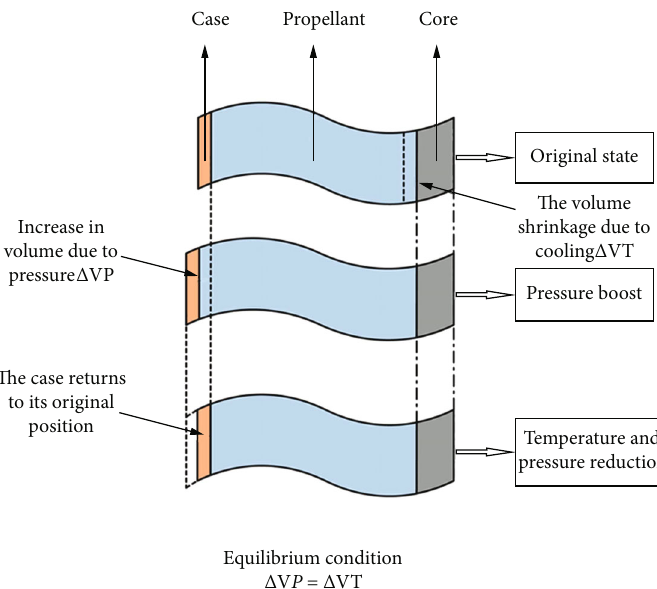
Figure 3: Principle of theoretical pressure calculation. Table 3: Parameters and interpretation. Parameter Numerical